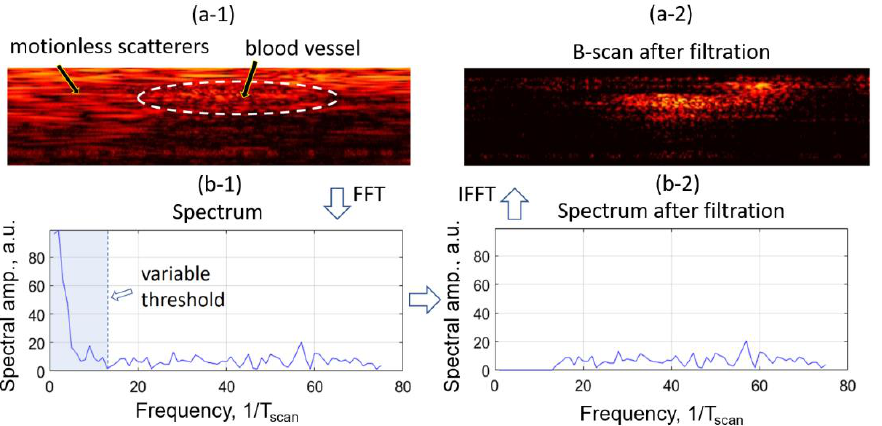
Figure 3. Schematic of the high pass filtering method. Fourier transform of B-scan is taken along a slow scanning direction (horizontal in the figure). Due to much higher speckle pattern variability inside the vessels (see panel ( a-1 )), they contribute to the high-frequencies range in the spectrum, whereas motionless tissue corresponds to low frequencies that can be filtered out (compare panels ( b-1 ) before filtering and ( b-2 ) after filtering). Therefore, high-pass filtering suppresses the “solid tissue” and makes vessels visible in the spatial-domain image constructed by inverse Fourier transform ( a-2